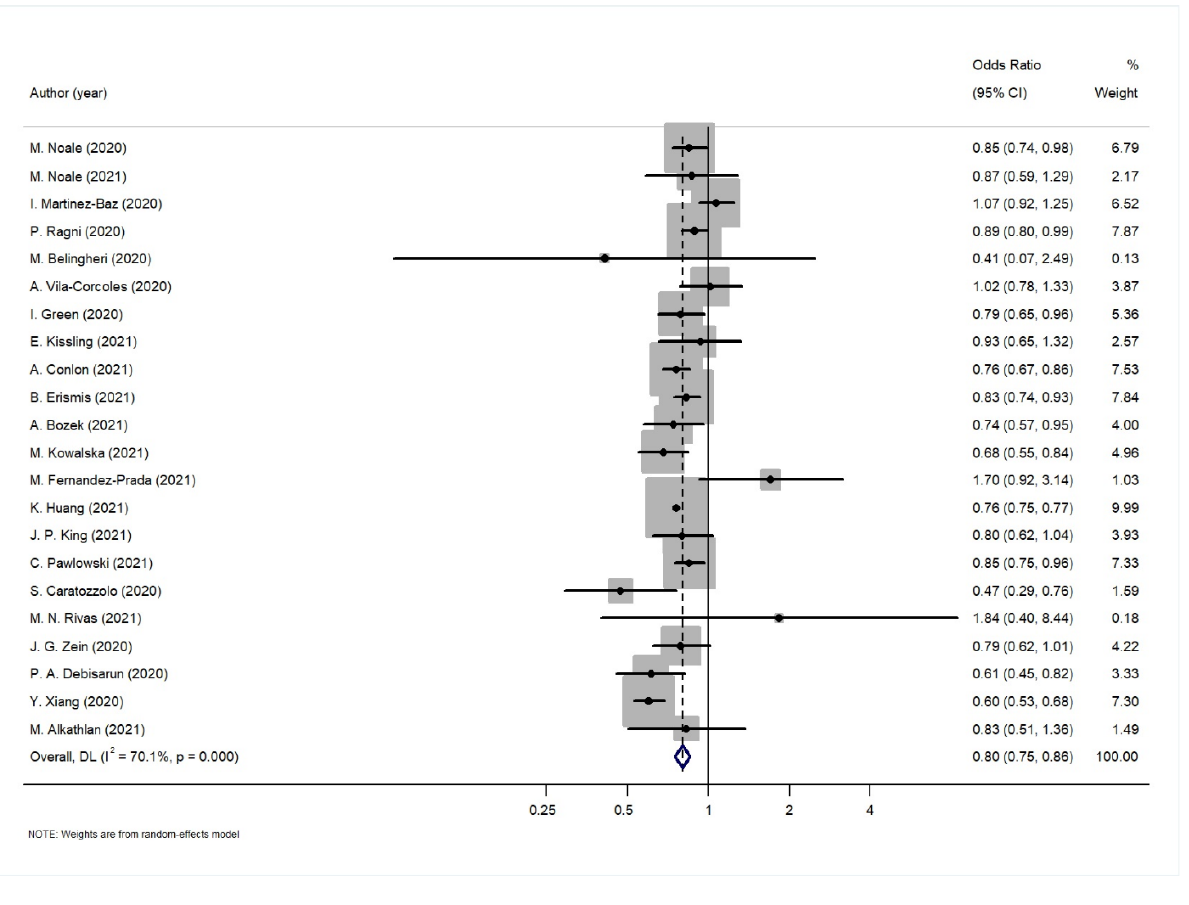
Figure 2. Forest plot for the association between influenza vaccination and SARS-Cov-2 infection. Table 5. Subgroup analysis of the association between influenza vaccination and SARS-CoV-2